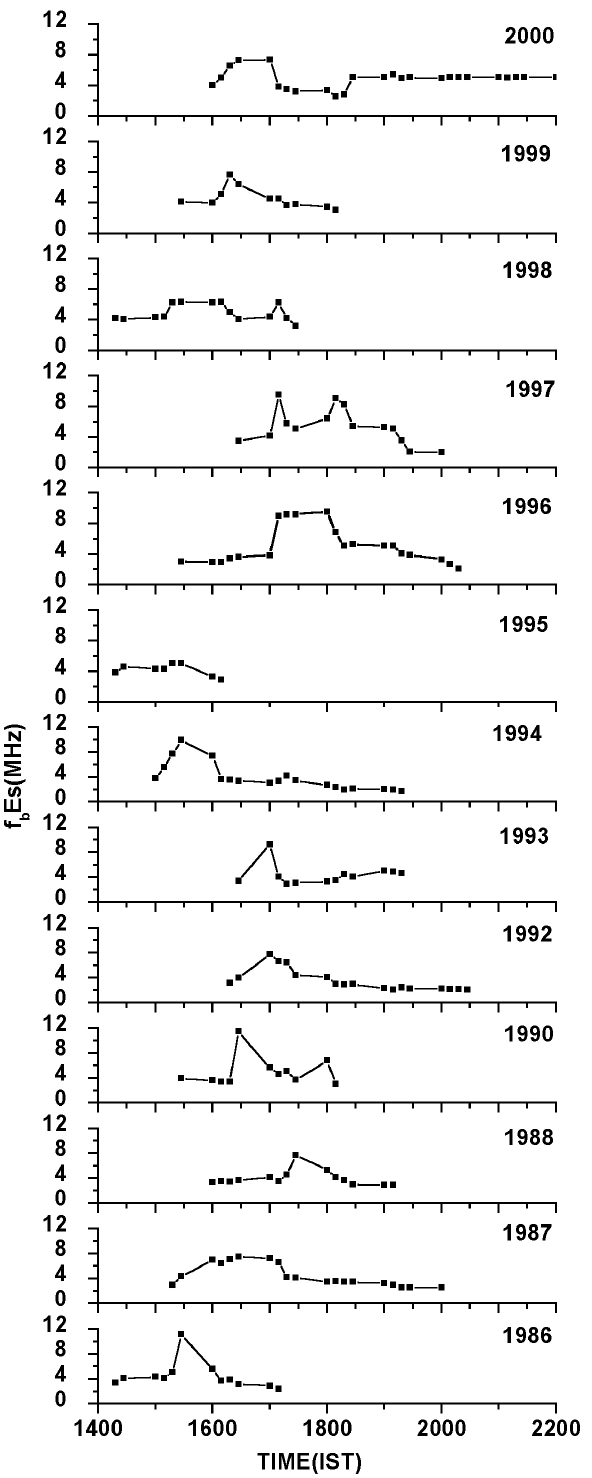
Fig. 8b. Time variation of h’E s corresponding to the same E sb